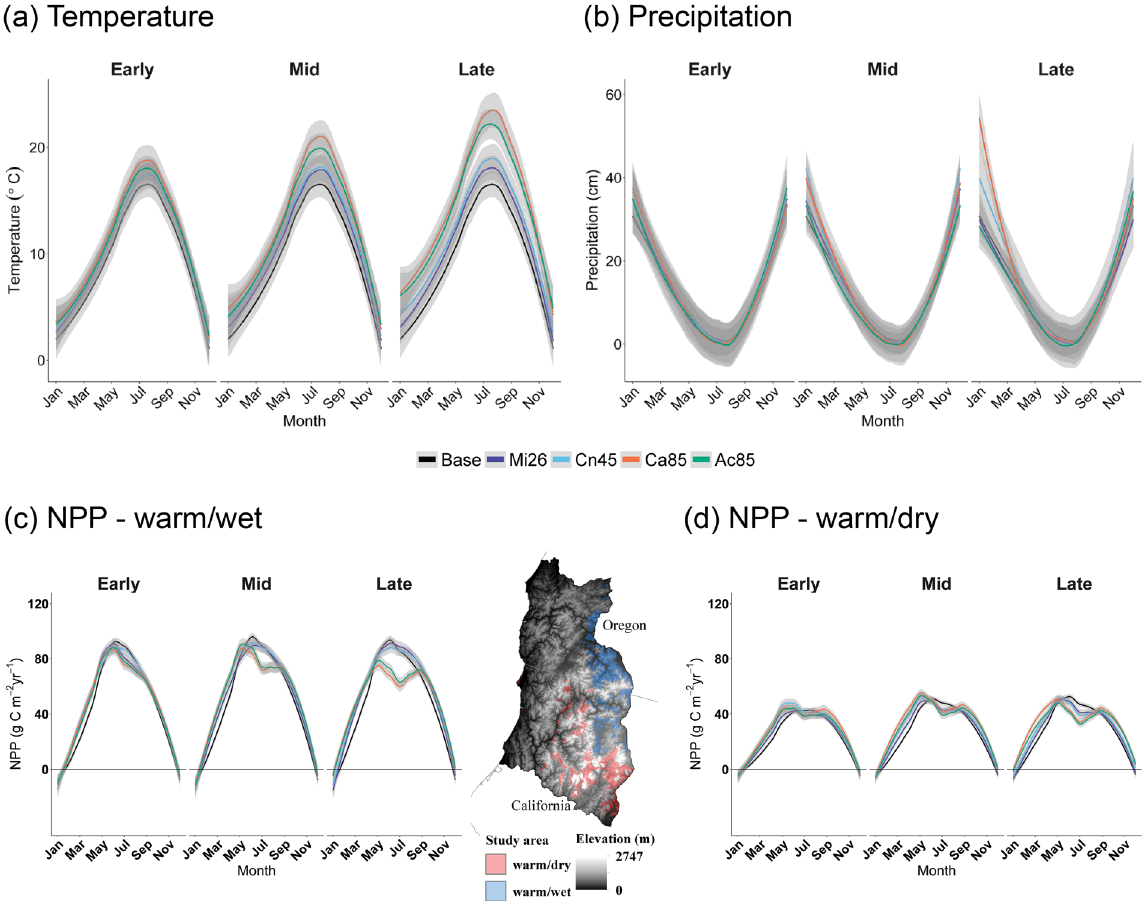
Figure 2. Climate seasonal regimes and the simulated effects on forest productivity. ( a ) Temperature and ( b ) Precipitation under baseline and climate change conditions for the Klamath landscape. Effects of climate on forest net primary productivity (NPP) in two locations chosen to highlight the model’s response to environmental gradient under all climate scenarios: ( c ) warm-wet and ( d ) warm-dry. See Table 1 for climate change scenario acronyms. Time-periods: Early 2015–2042, Mid 2043–2070, Late 2071–2100. Maps were created using ArcGIS v.10.5 (www.ersi.com/argis).